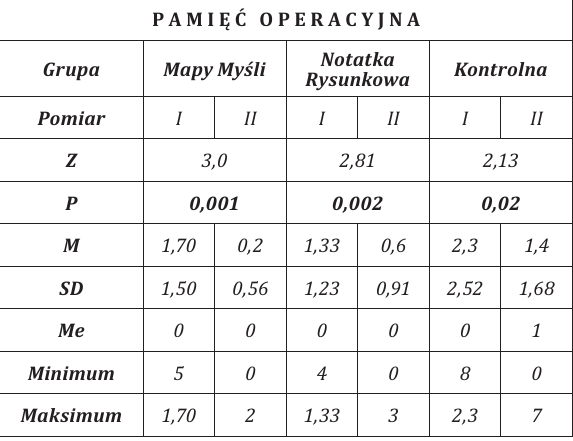
Tab. 2. Porównanie wyników średnich dla zmiennej